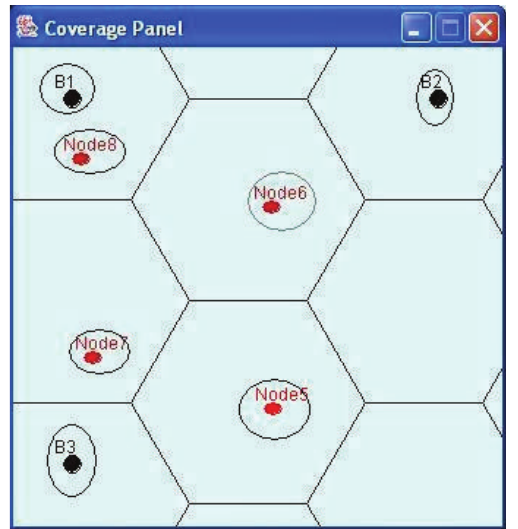
Figure 17: Coverage